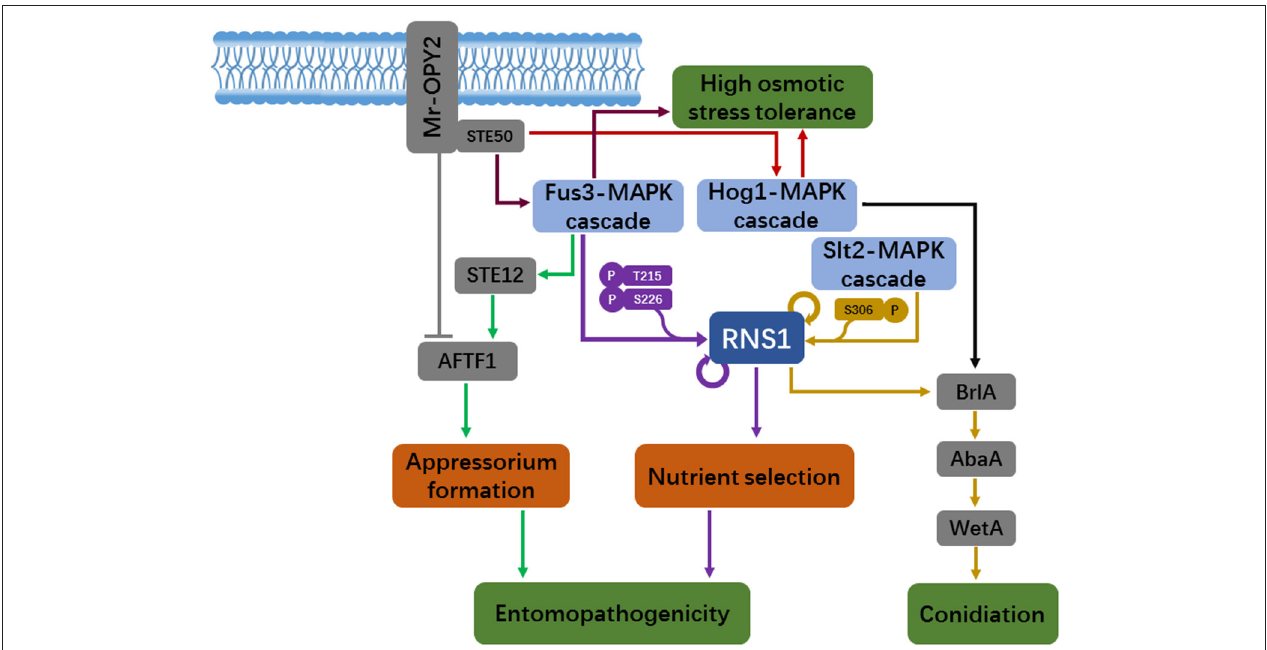
FIGURE 1 | A schematic model of new downstream signaling branches of the MAPK cascades, which regulate asexual reproduction, nutrient selection and insect infection in the fungus Metarhizium robertsii . Mr-OPY2-mediated regulation of the MAPK signaling pathways and the transcript factor AFTF1 for appressorial formation and osmotic stress tolerance is also shown. Arrows: induction; Dashes: